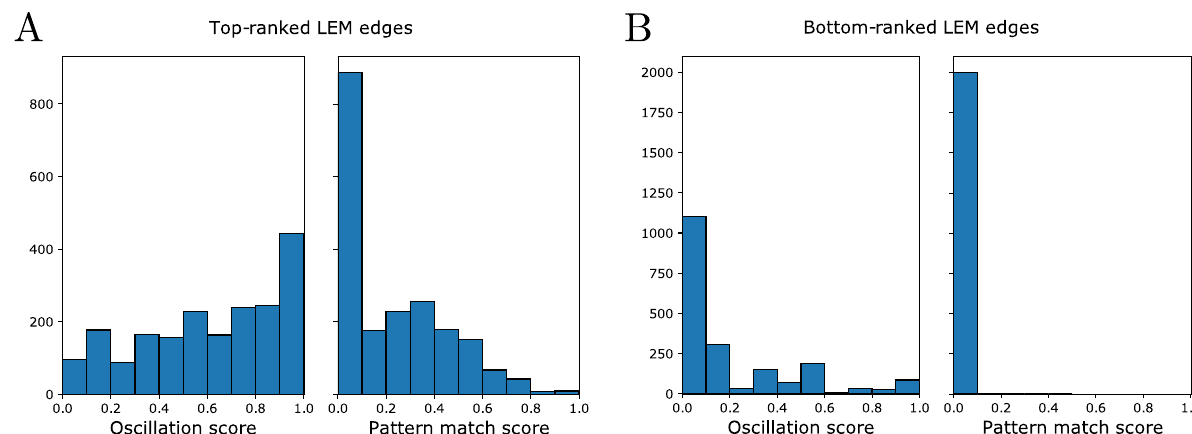
Fig 4. Histograms of the oscillation and pattern match scores of collections of 2000 networks using in panel A, the top-ranked LEM edges of a simulation for the parameterization in Fig 3B and in panel B, the bottom-ranked LEM edges for the same edge finding step.